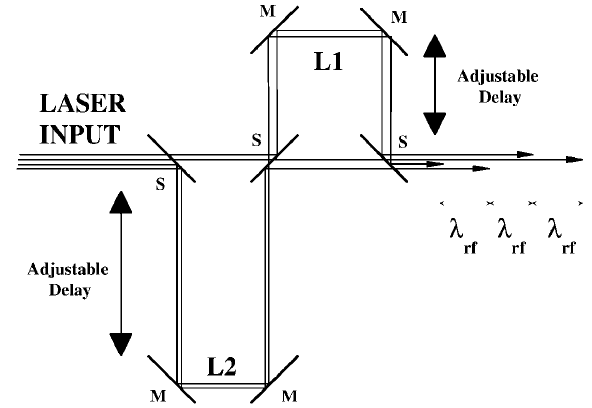
FIG. 5. Laser beam splitter optics. Three 50 (cid:1) 50 beam split- ters ( S ) in combination with four mirrors ( M ) are used to produce four laser pulses of variable separation. For this ex- periment, legs L1 and L2 are adjusted until the four pulses are separated by one wavelength of the rf ( l rf ) driving the photo- injector (lines separated for clarity.)